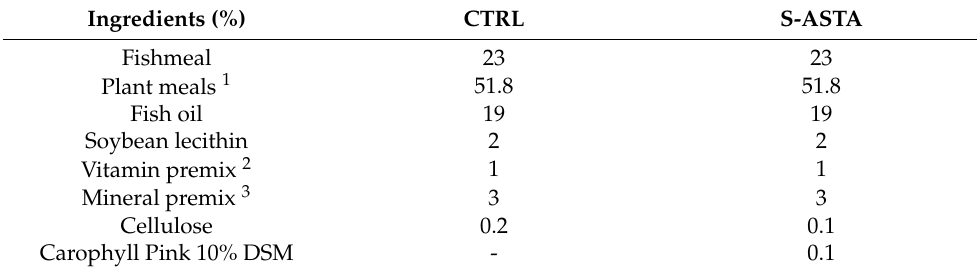
Table 1. Formulation of the experimental